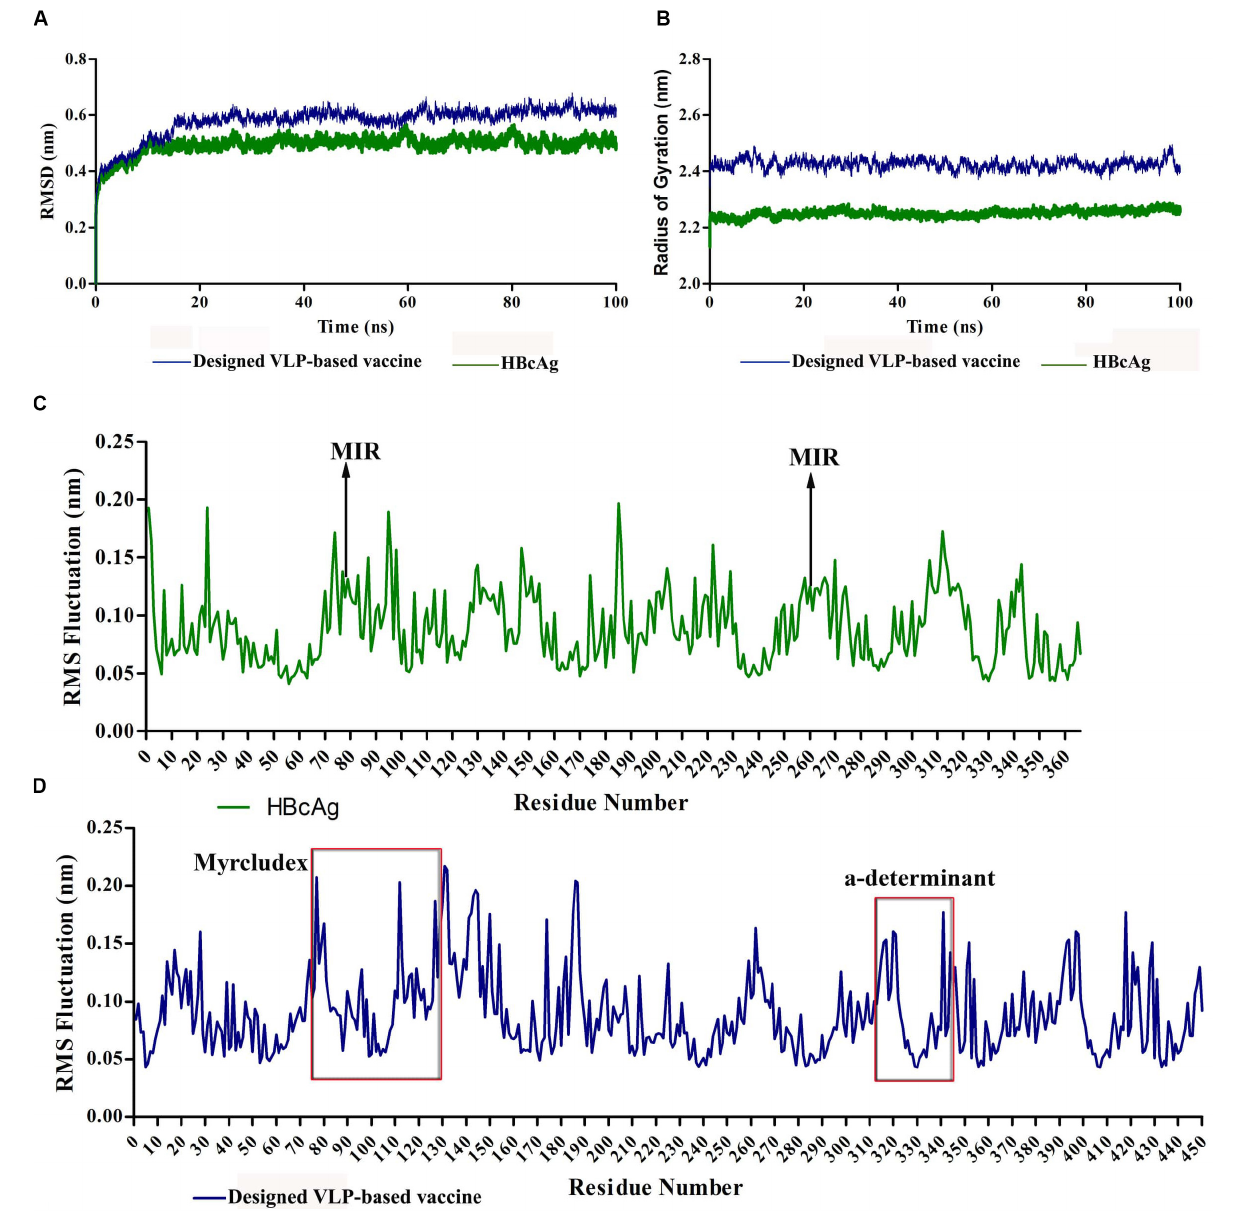
FIGURE 6 | Molecular dynamics (MD) analysis of hepatitis B core antigen (HBcAg) and the designed virus-like particle (VLP)-based vaccine during 100-ns simulations. (A) Root-mean-square deviation (RMSD) plot of proteins indicating acceptable stability of the structures. (B) Radius of gyration (RoG) plot of proteins representing stable folding of the structures. (C,D) Root-mean-square fluctuation (RMSF) plots of HBcAg and the designed vaccine, respectively. The red boxes indicate the region of inserted fragments into